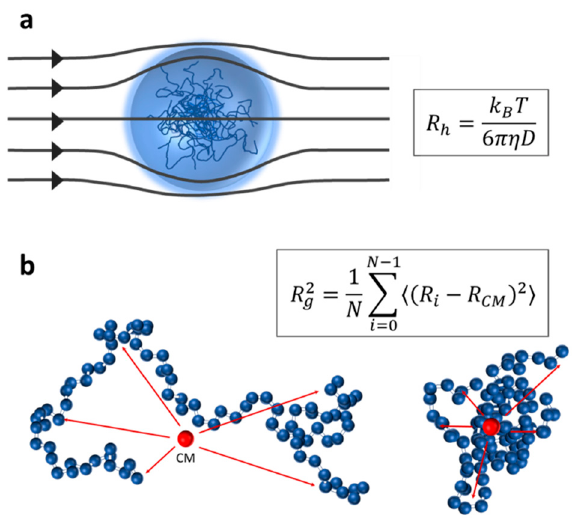
Figure A1. ( a ) Schematic representation and definition of R h (Figure adapted from [171]). ( b ) Schematic representation and definition of R g showing two conformations sampled from the ensemble of an ideal polymer, a freely jointed chain of 85 subunits, highlighting the position of their mass center (CM, at position R CM ) and its distance from given subunits at generic position R i . A bias toward compact or extended conformations, reshaping the conformational ensemble, results in different average distances between CM and each subunit and, hence, different <R g > values.